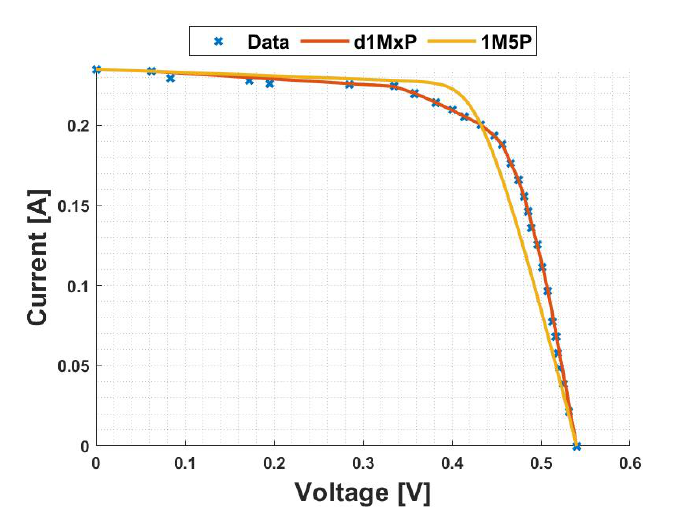
Figure 8. I-V curves using the 1M5P model and the proposed model, at T = 40 ◦